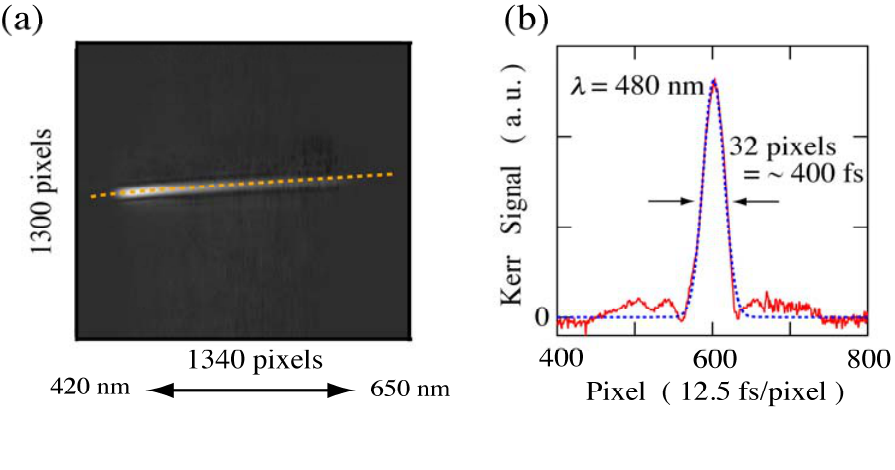
Figure 2. (a) Time-frequency 2D image of the probe beam (white light continuum) measured by the optical Kerr gate method with a 1 mm thickness quartz